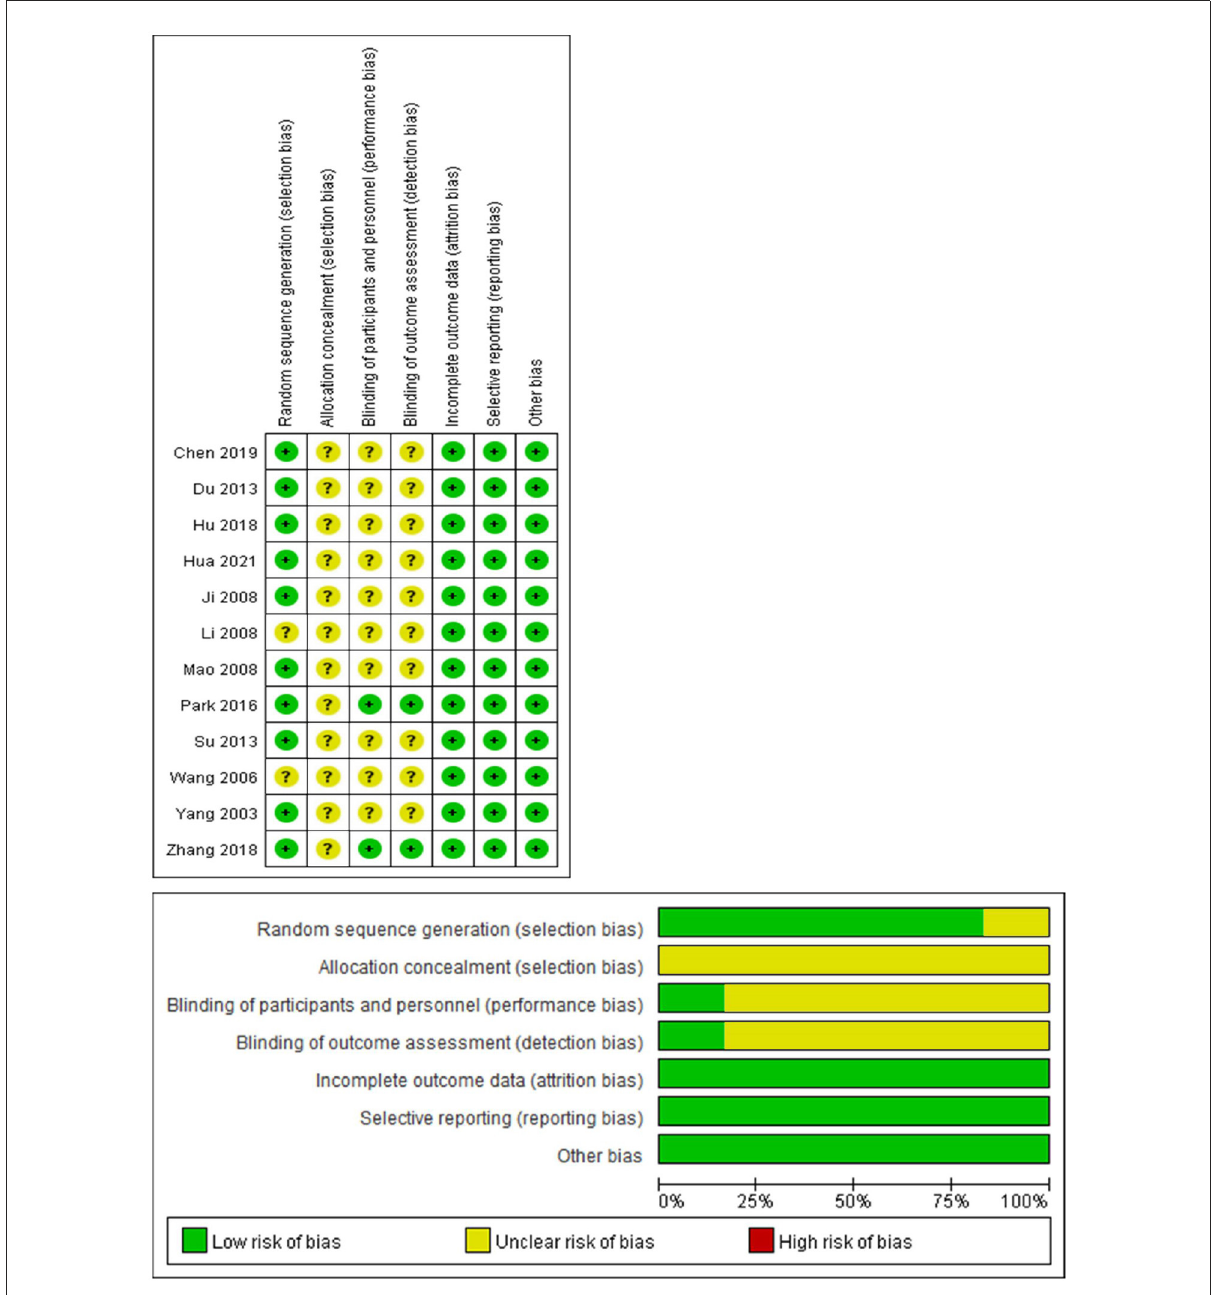
FIGURE2 Risk of bias assessment using Rob 2 for included